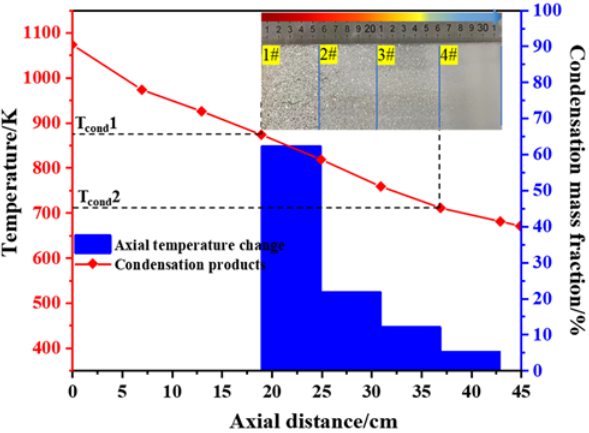
Figure 7. Graphite paper condensation product maps and SEM images of different condensation regions.